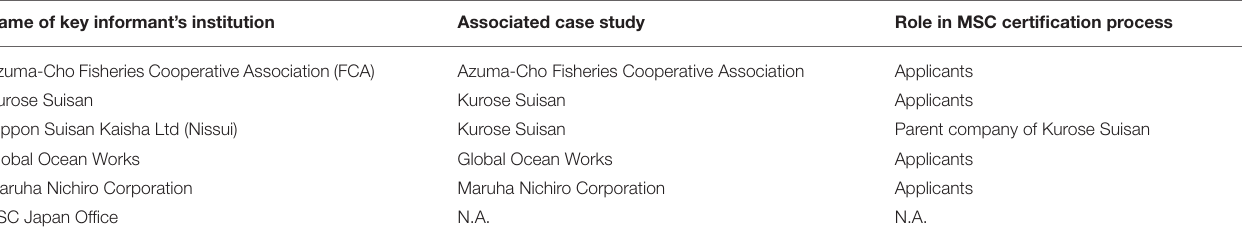
TABLE 3 | Details of key informants interviewed for each case study and their role within the ASC certification